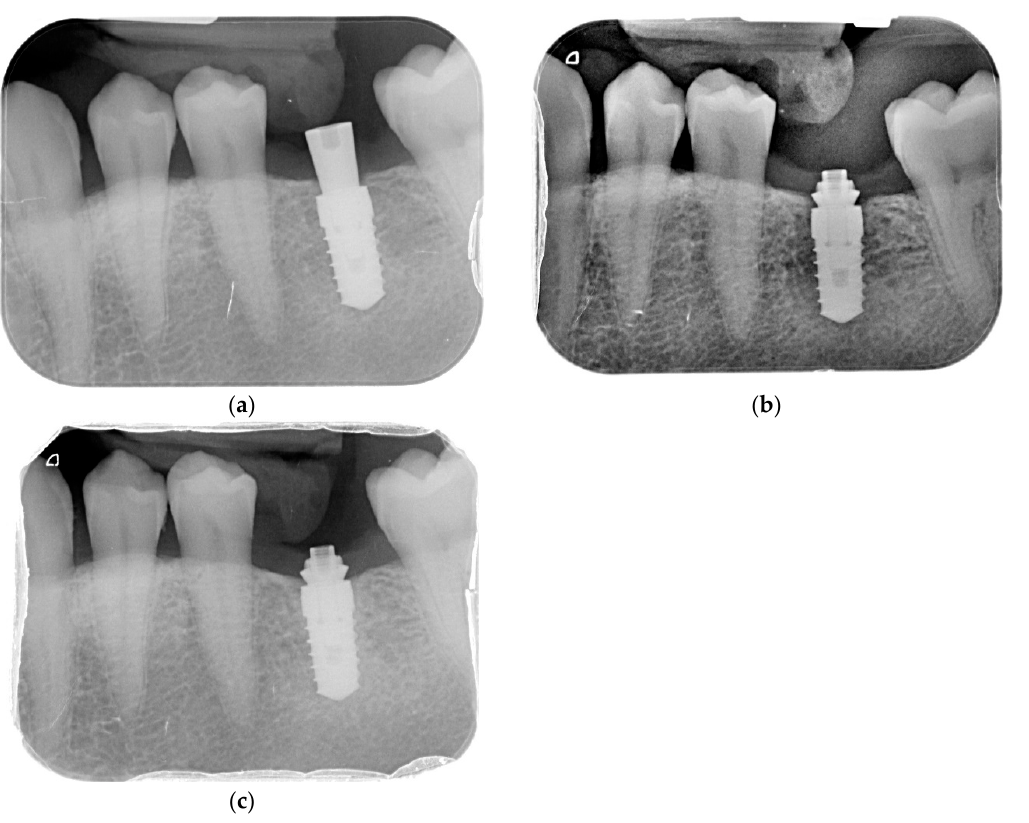
Figure 2. Case evolution. ( a ) Rx Baseline; ( b ) Rx 6 M; ( c ) Rx 12 M.